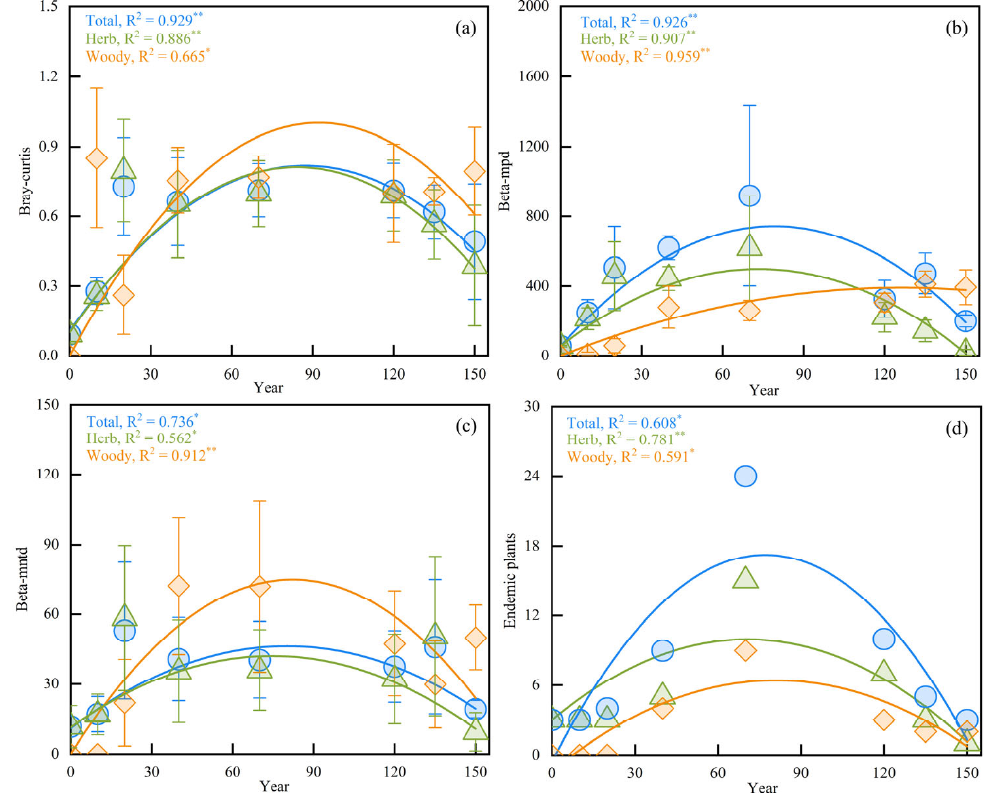
Figure 3. Trends in β -diversity of plant communities and endemic plants in different periods. ( a ) Trends in the Bray-Curtis dissimilarity index of plant communities with vegetation restoration; ( b ) Trends in beta diversity index of the mean pairwise phylogenetic distance (Beta-mpd) of plant community with vegetation restoration; ( c ) Trends in beta diversity index of the mean nearest taxon phylogenetic distance (Beta-mntd) of plant community with vegetation restoration; ( d ) Trends in the endemic plants at each stage with vegetation restoration; **— p < 0.01; *— p < 0.05. Endemic plants occur in one stage only. “Total” represents the overall plant level of the investigated plant communities. “Herb” represents the herb plant level in the investigated plant communities. “Woody” represents the woody plant level in the investigated plant